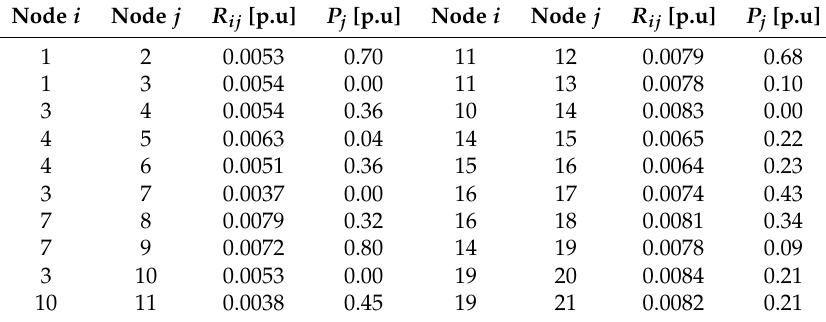
Figure 1. Electrical connection between nodes in the 21-node test feeder. Table 1. Parametric information of the 21-node test